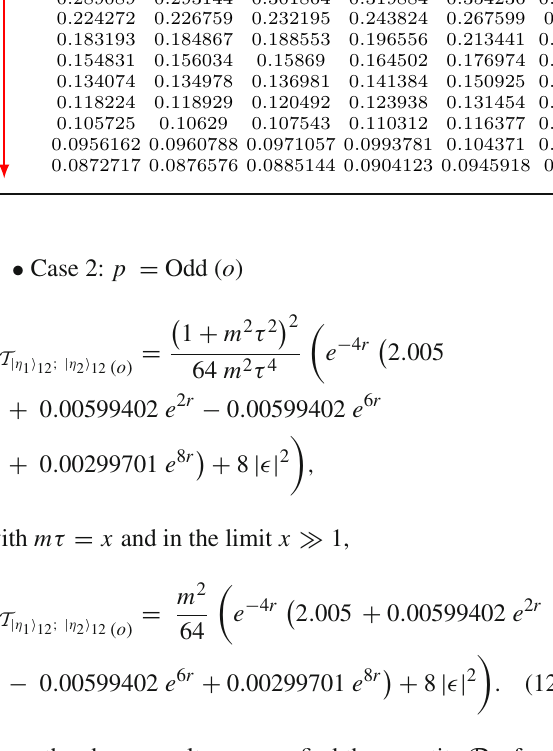
:(cid:3) 2 00 (cid:3); | η (cid:3) ) and hence | η 1 2